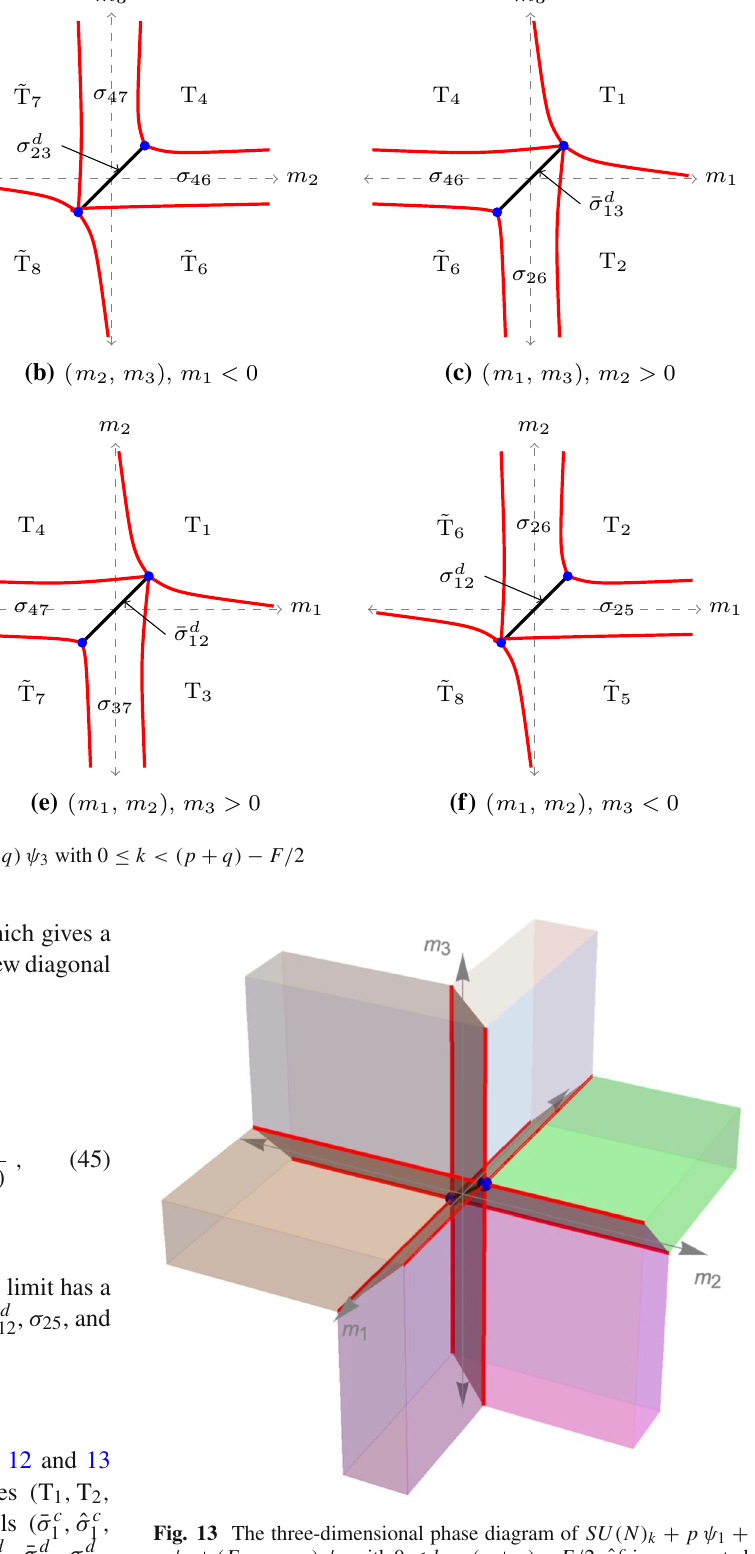
is represented 1 is the white 2